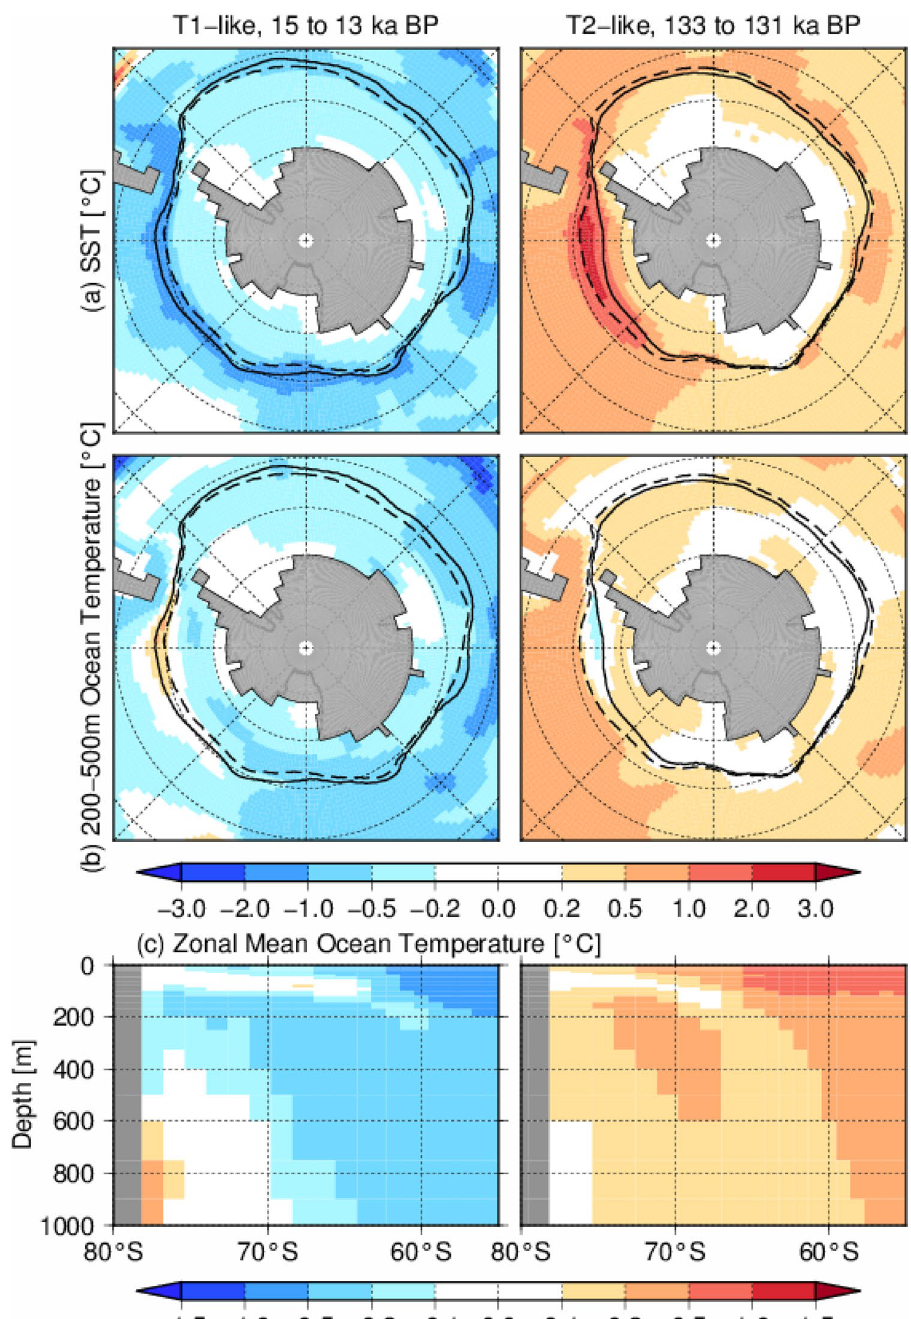
Figure 3. Ocean temperature changes in the T1-like (15–13 ka BP) and T2-like (133–131 ka BP) experiments, corresponding to the Antarctic Cold Reversal of T1. ( a , b ) SST and subsurface ocean temperature averaged at 200–500 m depth. Dashed and bold lines indicate austral winter sea ice extent, defined by a sea ice concentration of 15%, at 15 and 13 ka (left panels), and 133 and 131 ka (right panels), respectively. ( c ) Zonal mean ocean temperature averaged for the whole of Antarctica. The maps were generated using GMT version 4.5.9 (URL: https:// www. soest. hawaii. edu/